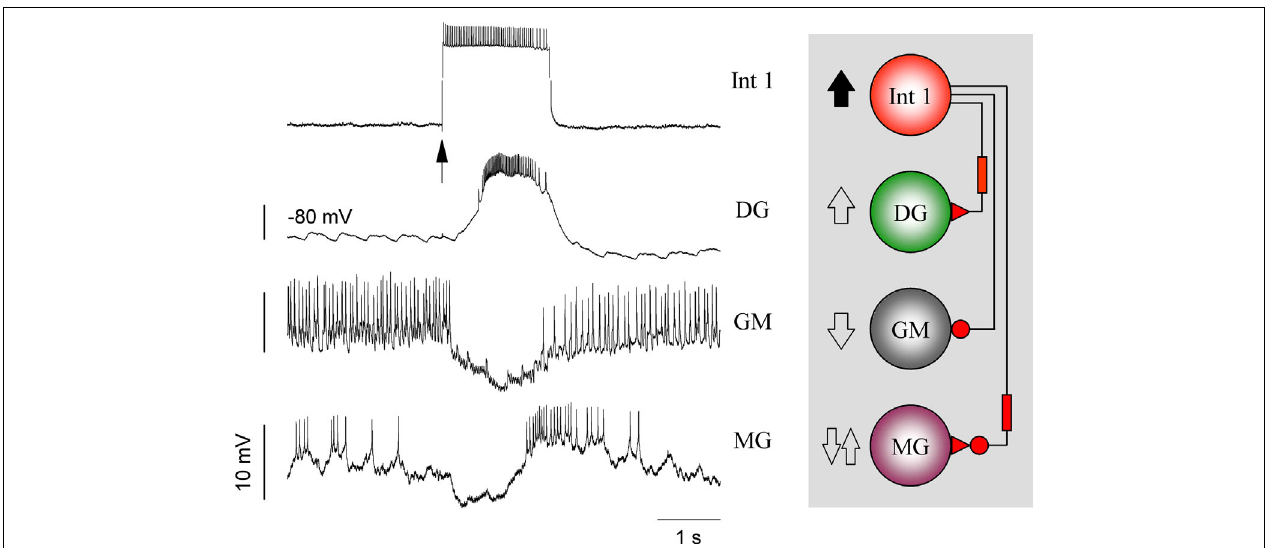
FIGURE 8 | The role of Int 1 in synchronizing the medial and lateral subsets. A depolarizing pulse to Int1 reliably excites DG after a delay. At the same time, the GM is inhibited while the MG is inhibited then